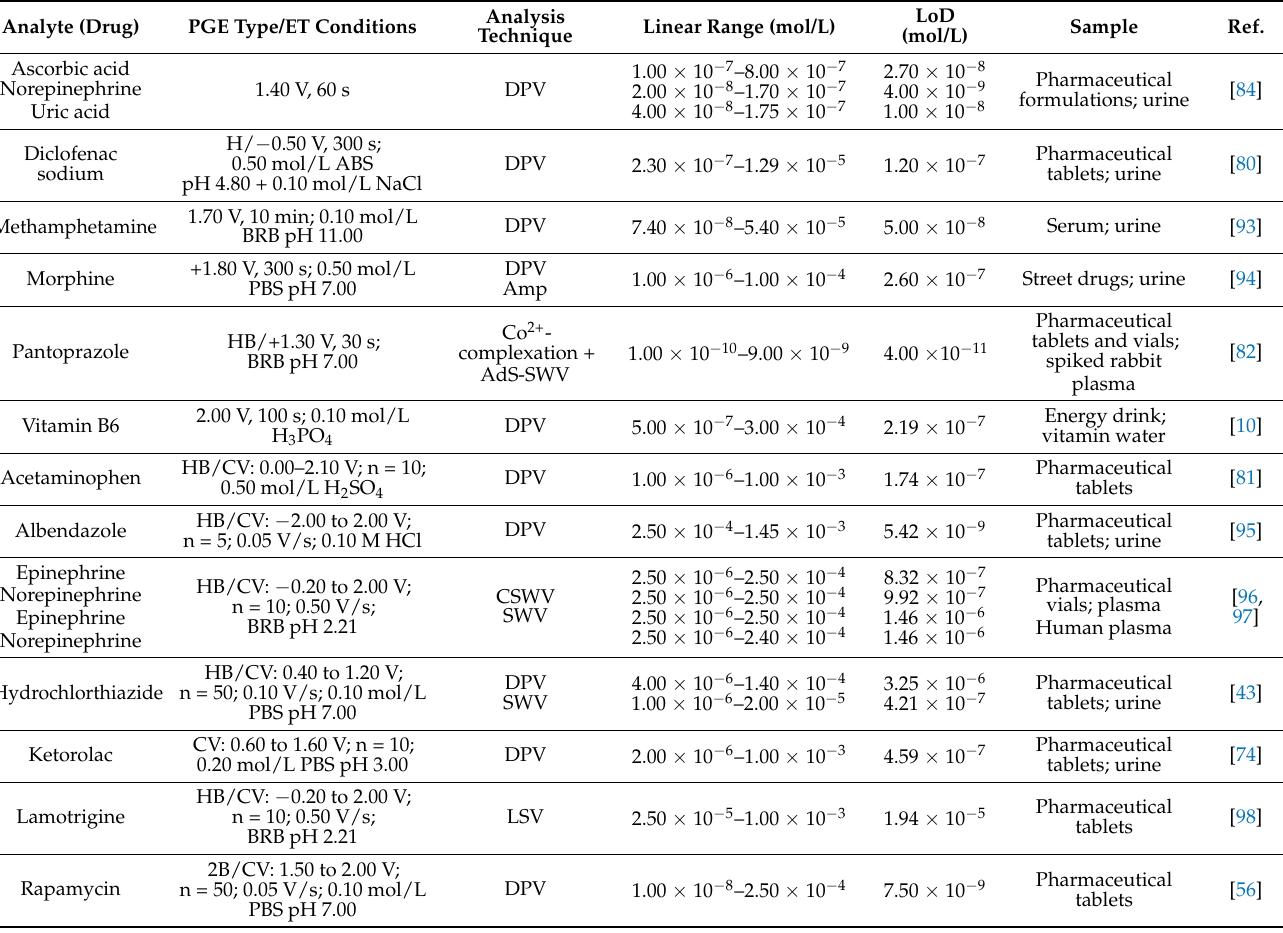
Table 2. The performance characteristics of voltametric methods developed for drug quantitative determination at